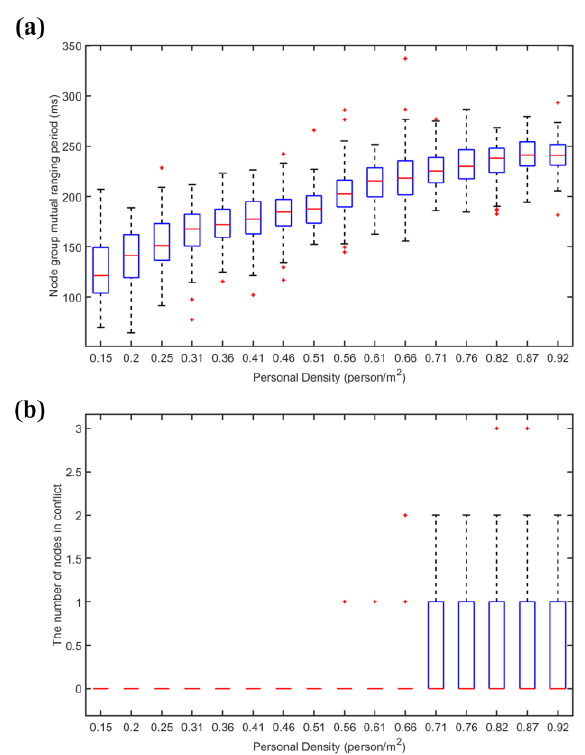
Figure 30. Hybrid channel access simulation results. ( a ) The total period of node cluster mutual ranging under hybrid channel access. ( b ) The number of nodes colliding with hybrid channel access.